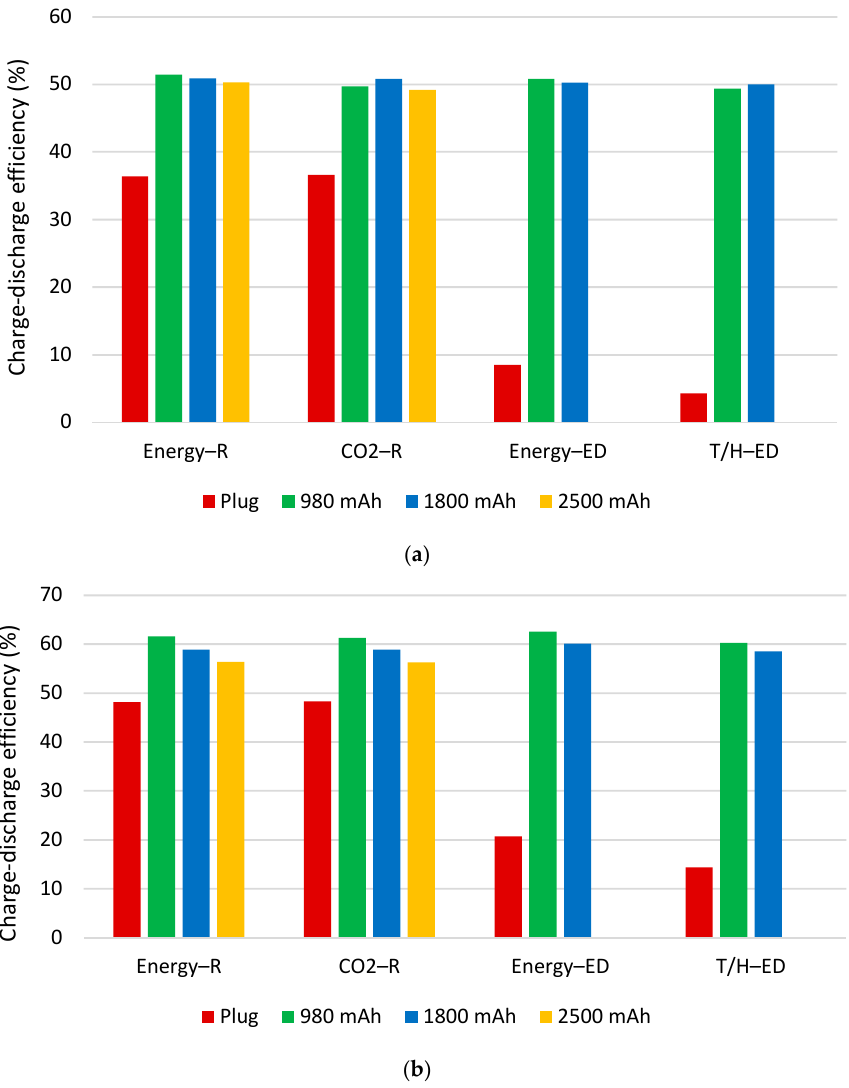
Figure 12. Efficiencies obtained for sensor nodes with the proposed system: ( a ) batteries charged by the 230 V AC system; ( b ) batteries charged by the 12 V DC system.